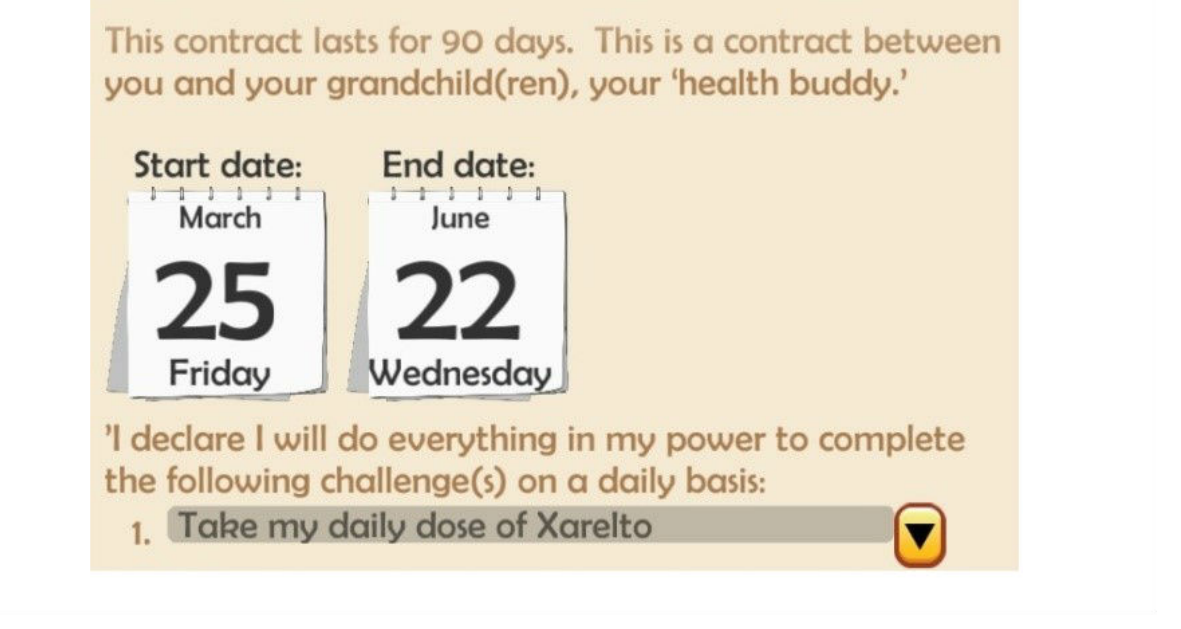
Figure 2. Screenshot of the Health Buddies app showing the check box that patients receive daily to indicate if they have completed their